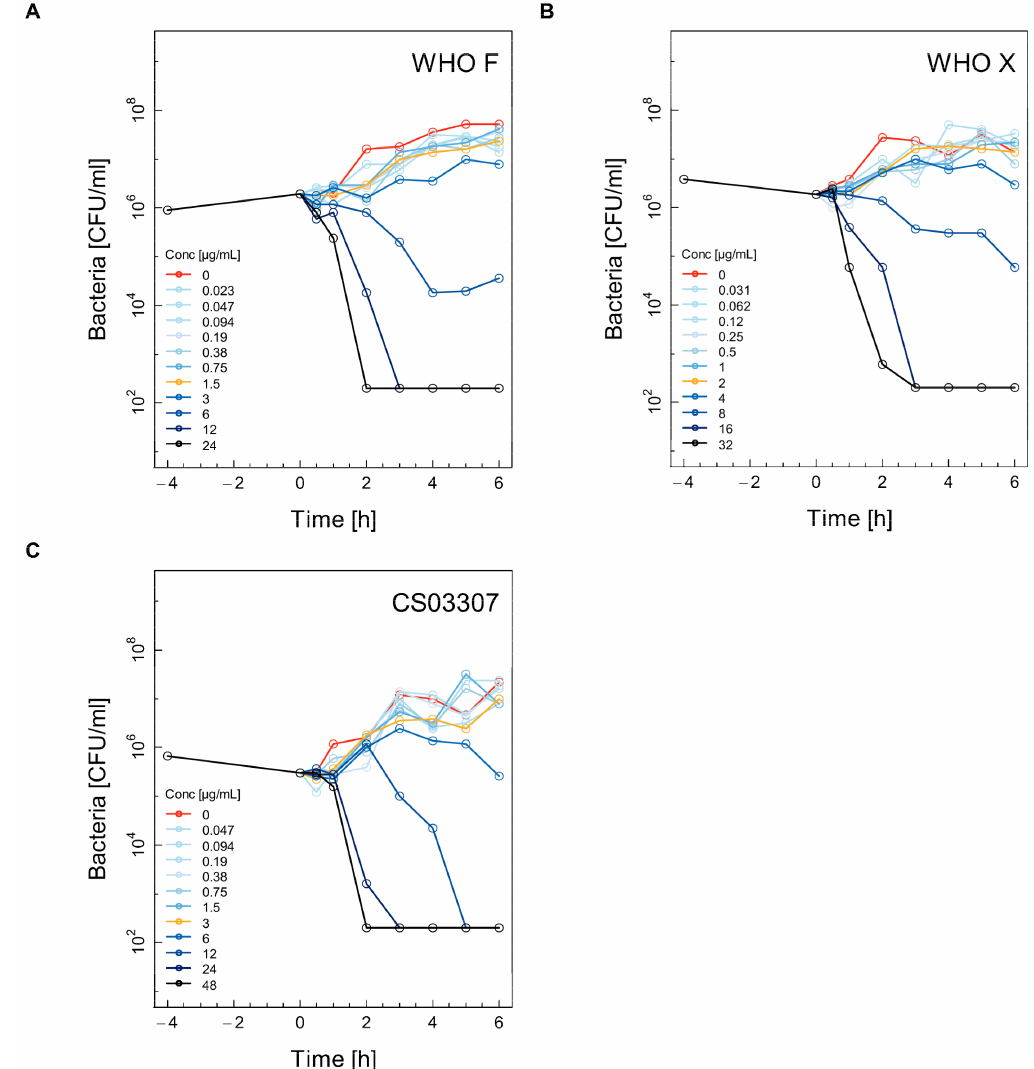
Figure 4. Selected time–kill curves (TKC) for three different strains of Neisseria gonorrhoeae using gentamicin. For each combination of antibiotic and strain, the TKC from one of the three independent experiments is shown: WHO F ( A ), WHO X ( B ), CS03307 ( C ). See the legend for Figure 1 for further